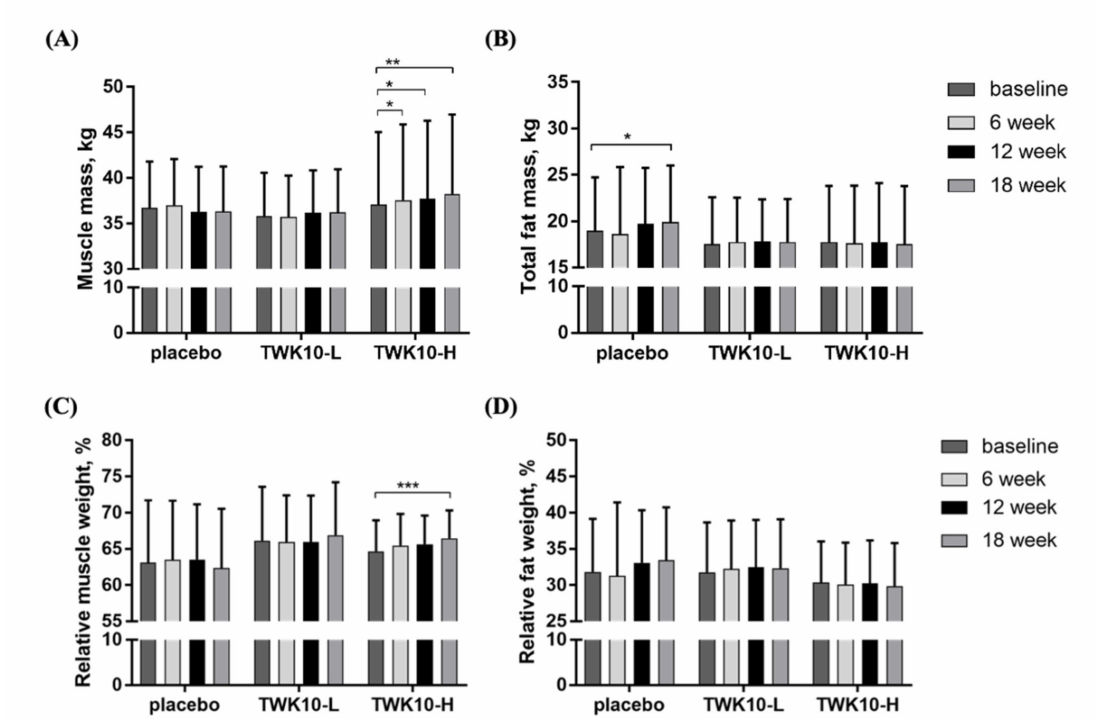
Figure 4. Effect of TWK10 supplementation in elderly on ( A ) muscle mass, ( B ) fat mass, ( C ) relative muscle mass, and ( D ) relative fat mass at baseline, 6th, 12th, and 18th weeks, respectively, in placebo group (n = 17), TWK10-L (n = 12), and TWK10-H (n = 13). Data are expressed as mean ± SD. * p < 0.05, ** p < 0.01, *** p < 0.001 vs. baseline of each